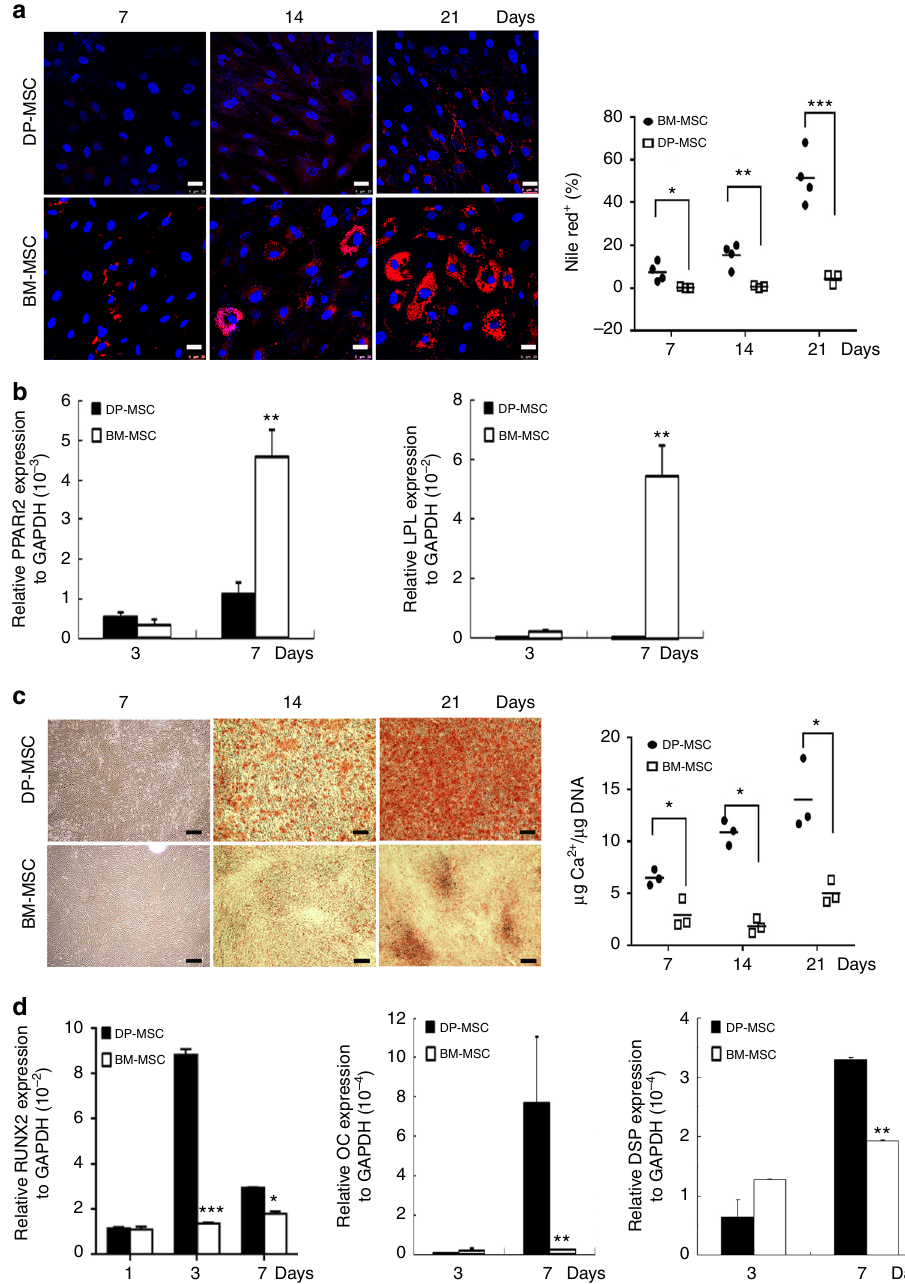
Fig. 1 DP-MSCs decrease in adipogenesis and increases in osteogenesis. Comparison of adipogenic ( a , b ) and osteogenic potential ( c , d ) between DP- MSCs and BM-MSCs. a Cells were induced in an adipogenic induction medium for up to 21 days. (Left) Cells were stained by nile red, and (Right) quanti fi cation of the nile red positive cell percentages. Bar = 25 μ m. b Quantitative RT-PCR for mRNA levels at indicated time of adipogenic differentiation. c Cells were induced in an osteogenic induction medium for up to 21 days. (Left) Cells were analyzed by Arsenazo III kit, and (Right) the calcium contents were quanti fi ed relative to DNA contents. d Quantitative RT-PCR for mRNA levels at indicated time of osteogenic differentiation. Results are expressed as the mean ± SD of three independent experiments. * p < 0.05; ** p < 0.01 versus DP determined by Student ’ s t -test. Bar = 200 μ m itself was downregulated in BM-MSCs compared to DP-MSCs ( p - plays a critical role in regulating the differential abilities of cell value with FDR correction = 0.0008, fold change = − 2.50). There differentiation and carcinogenesis between BM-MSCs and DP- were 582 genes in the union of differentially expressed genes MSCs. associated with adipocyte differentiation, bone cell differentiation, and bone marrow neoplasm (Supplementary Table 1), among which 272 genes were downstream targets of PTEN pathway as Differences in insulin signaling and the PI3K/AKT pathway . analyzed by using IPA Path Explorer (Fig. 2e). Several molecules To con fi rm PTEN pathway upregulation in DP-MSCs, the PTEN in PTEN signaling seem to be regulatory hubs, e.g., PTEN and level, the PTEN-targeted insulin signaling, and its downstream EGFR. Therefore, our results implied that the PTEN pathway molecule AKT were explored. Western blotting revealed that NATURE COMMUNICATIONS| (2019) 10:2226